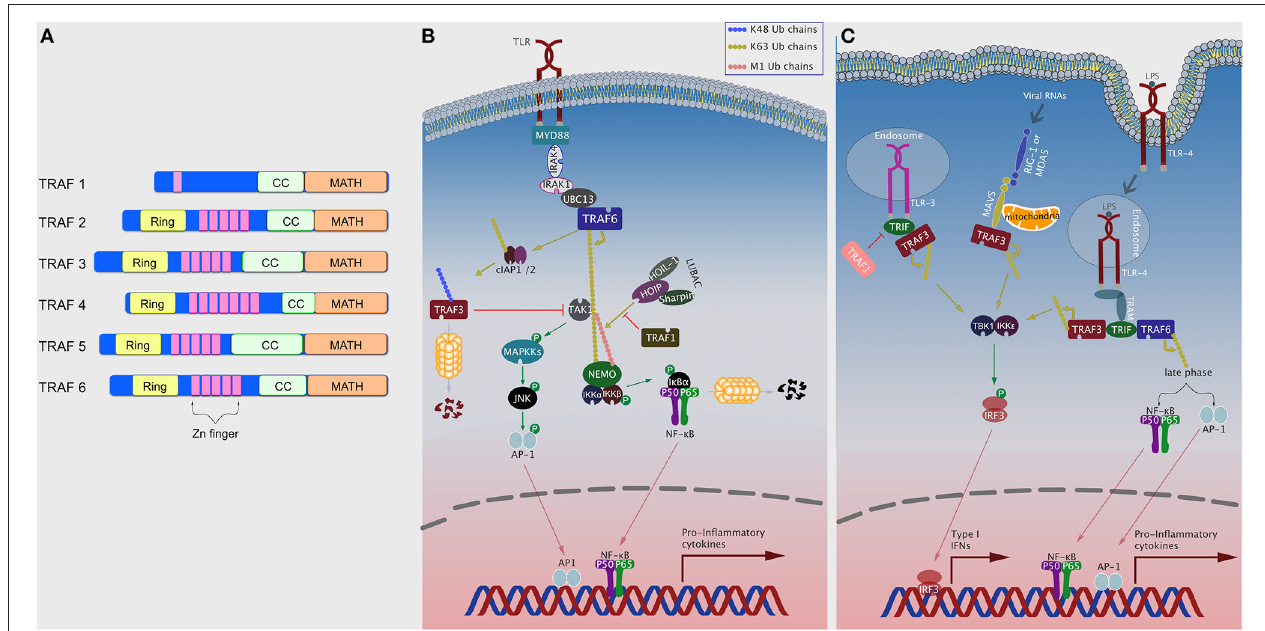
FIGURE 1 | TRAFs in TLR signaling pathways. (A) Domain organization of TRAF proteins. Domains shown include Ring, Zinc (Zn) finger, coiled-coil (CC; TRAF-N), and MATH (TRAF-C) (B) Plasma membrane TLRs, upon ligand binding, recruit various intracellular signaling elements including TRAF6 to activate NF- κ B and